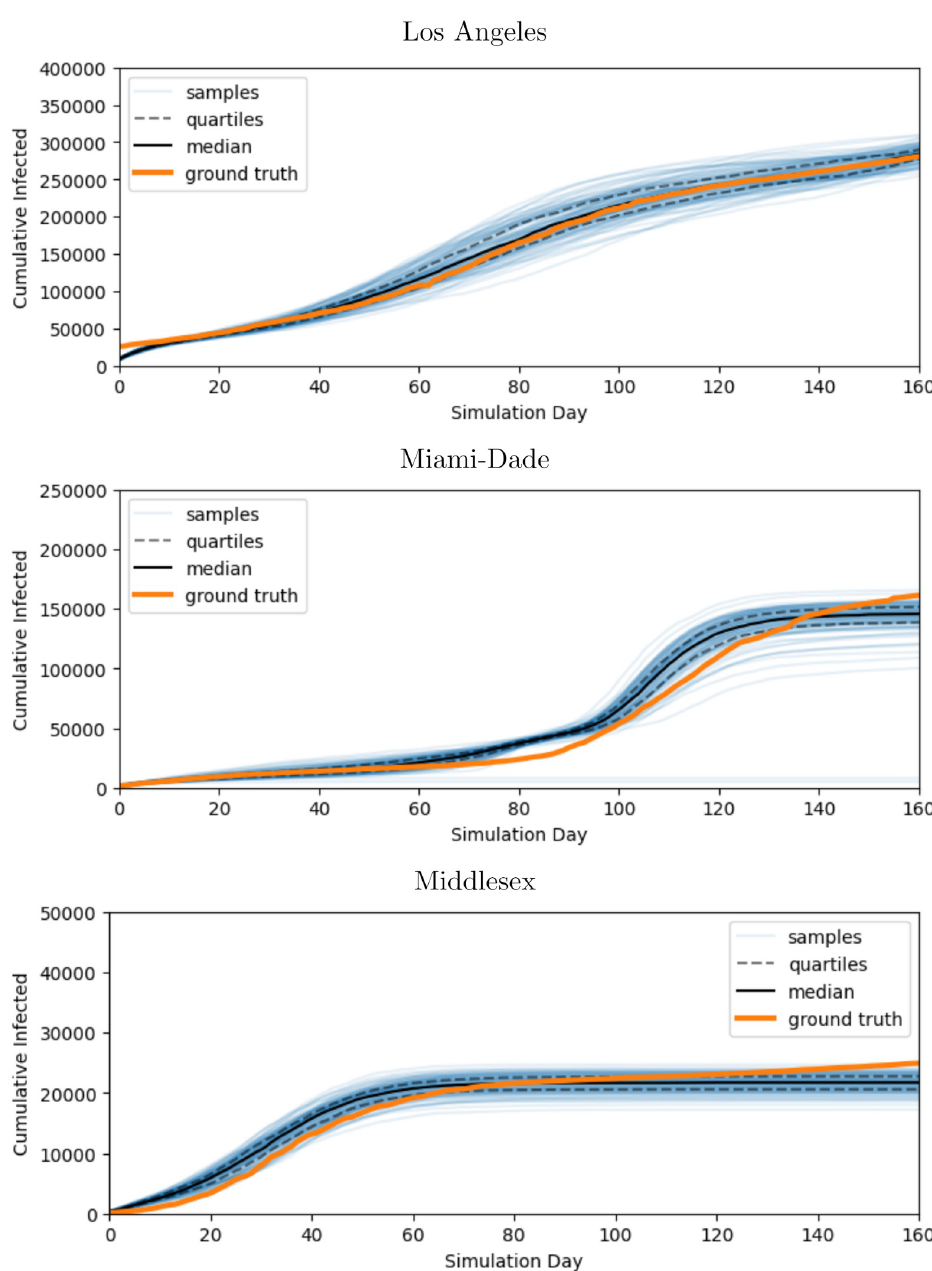
Fig 9. Cumulative infection trajectories sampled from fitted model. Our method is capable of obtaining distributions of disease parameters which reproduce true data closely over a variety of regions. The orange line represents true cumulative infections counts for 160 days starting from 7 days before the first day in which infections counts accounted for 0.5% of the population: May 3, 2020 for Los Angeles, March 29, 2020 for Miami-Dade, and March 15, 2020 for Middlesex. The blue lines represent 100 simulations of f using disease parameters sampled from NSEIR our fit variational distribution. The black lines represent quartiles for these 100 samples.